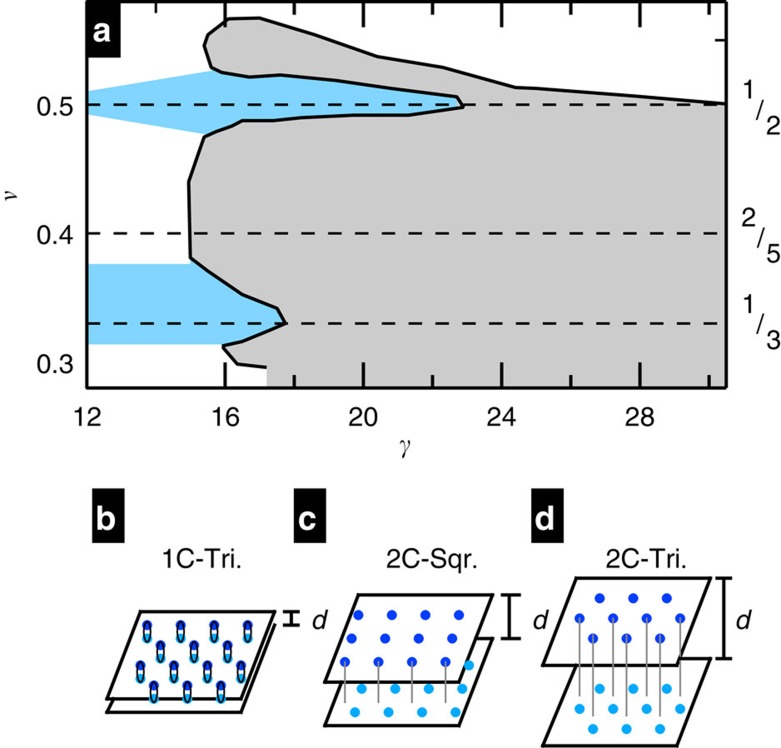
Wide quantum well overview.(a) Phase diagram in the γ–ν plane, where ν is the Landau filling and γ is the Coulomb energy (e2/4πε0εℓB) divided by the interlayer tunnelling gap. The insulating area is shaded grey, and the ranges of the FQHE states at ν=1/2 and ν=1/3 are shaded blue. Horizontal dashed lines mark ν=1/2, 2/5 and 1/3. (b–d) Different possible structures for bilayer Wigner solids as layer separation, d, increases for fixed n. A 1C triangular (tri.) structure (b), proceeds to a 2C staggered square (sqr.) structure (c) and then to a 2C staggered triangular (tri.) structure (d).